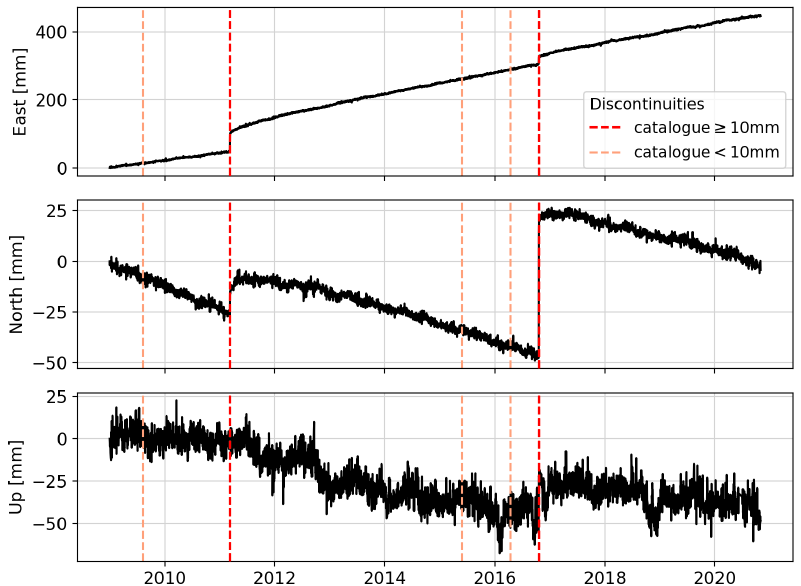
Figure 1. GPS station coordinate time series of the station G016 for the east, north and up component. The vertical dashed lines mark potential earthquake discontinuities from the NGL discontinuity database. Light red lines mark discontinuities causing a station coordinate displacement smaller than ten millimeters in one of the components, while dark red lines mark discontinuities causing a station coordinate displacement equal to or larger than ten millimeters in one of the